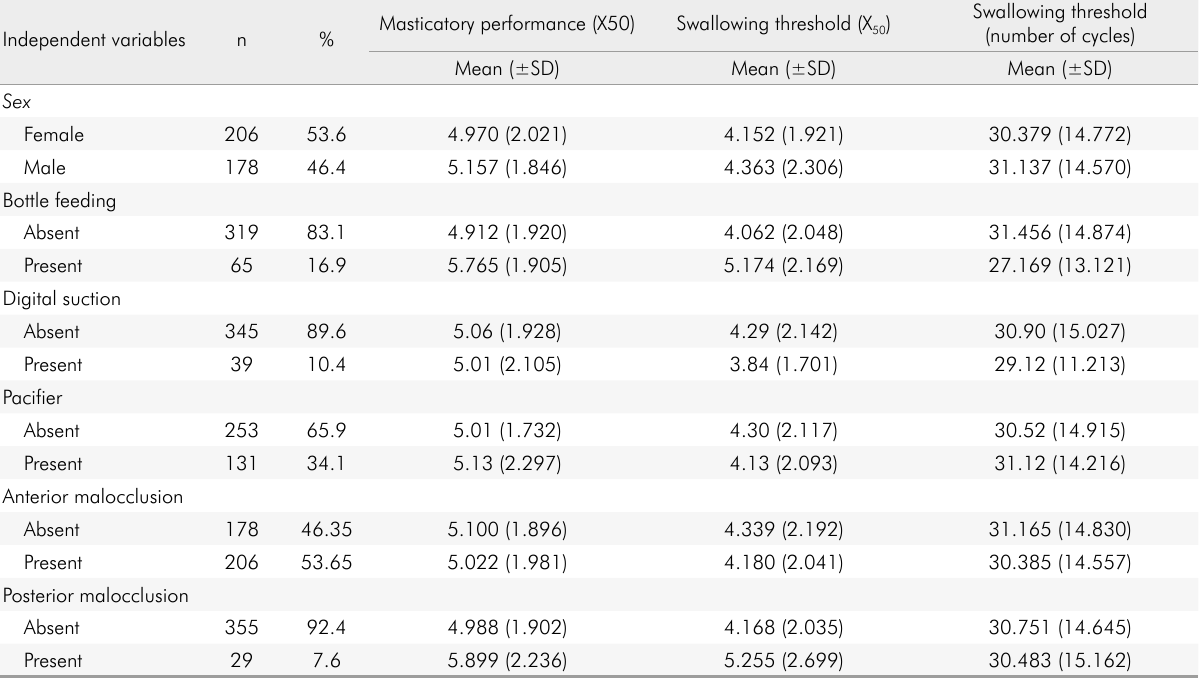
Table 1. Characterization and distribution of independent variables according to parameters of masticatory function (n = 384, Diamantina,